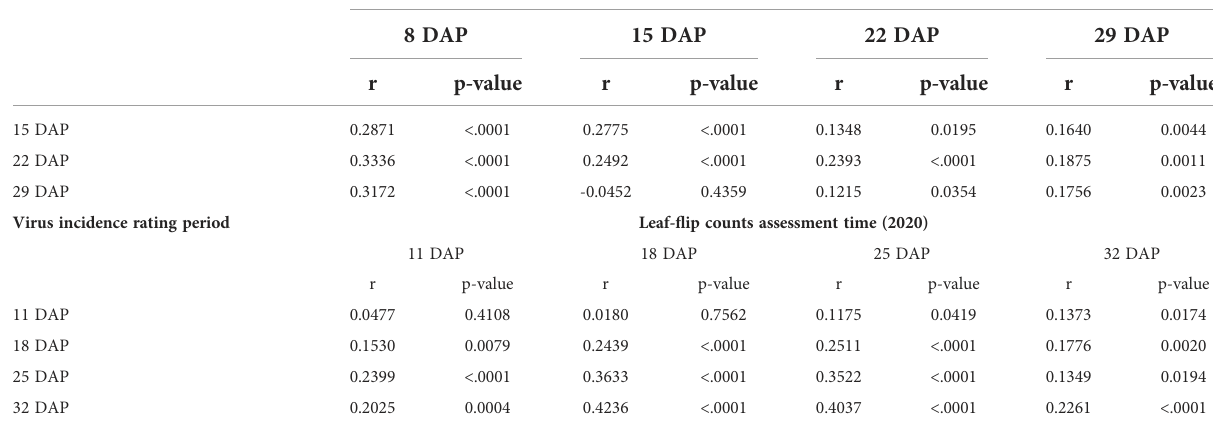
TABLE 3 Correlation matrix of white fl y counts from leaf- fl ips and WTVC incidence experimental fi eld trials conducted at the University of Georgia Black Shank Farm, Tifton, Georgia, USA in 2019 and 2020. Virus incidence rating